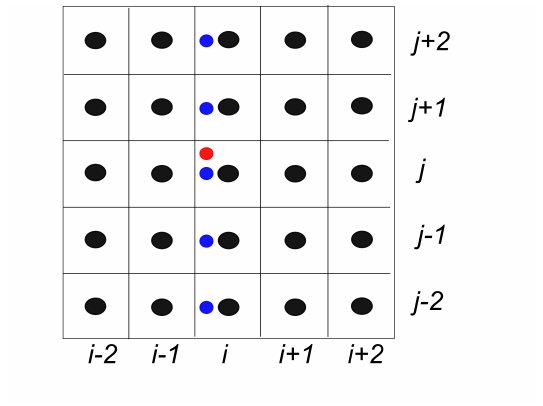
Figure 2. Two-dimensional WENO interpolation.